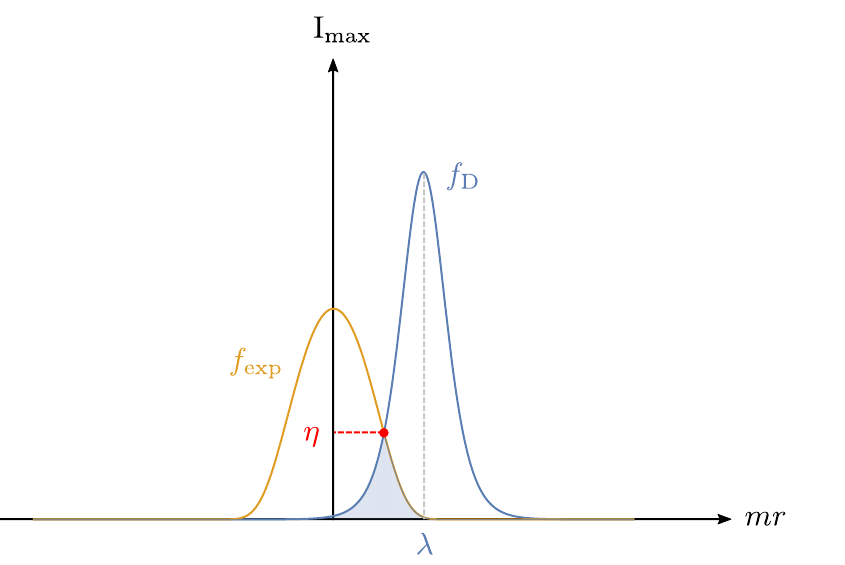
Figure 6 . Overlap of f exp and f D . The unit of the two axis are mr and I max ,